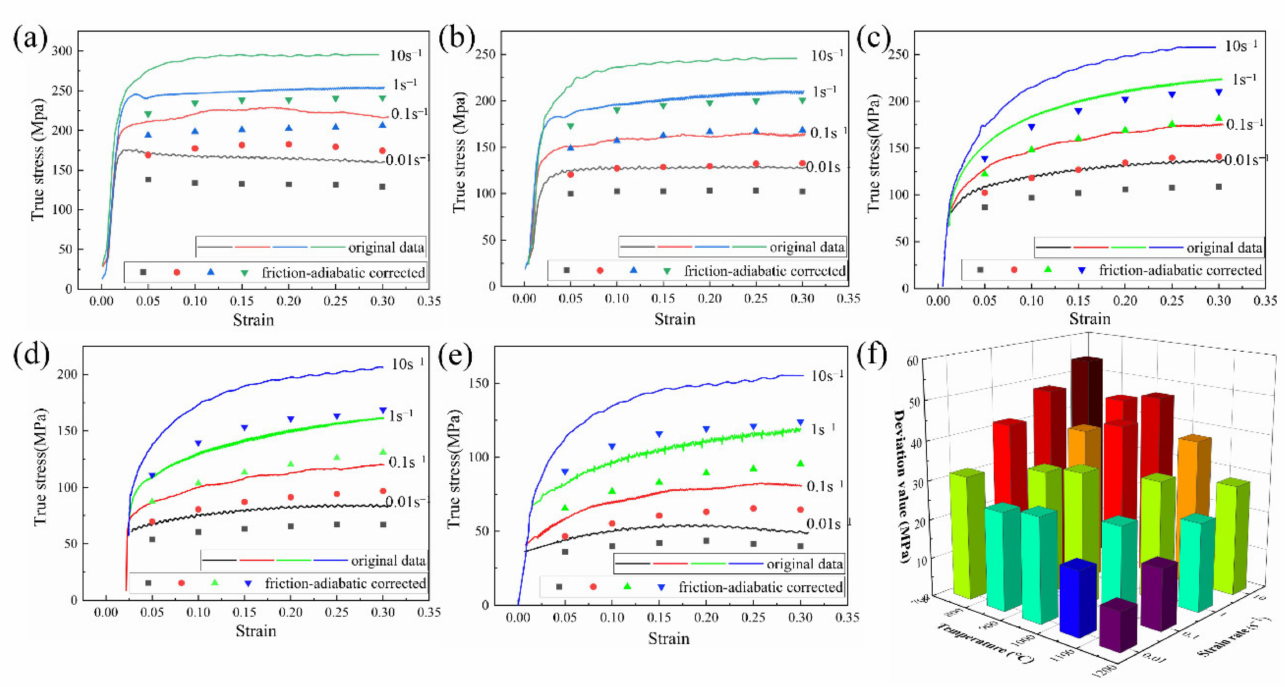
Figure 6. Original stress and friction-adiabatic-corrected stress (0.3) at different temperatures: ( a ) 750 ◦ C, ( b ) 850 ◦ C, ( c ) 950 ◦ C, ( d ) 1050 ◦ C, ( e ) 1150 ◦ C; ( f ) stress deviation